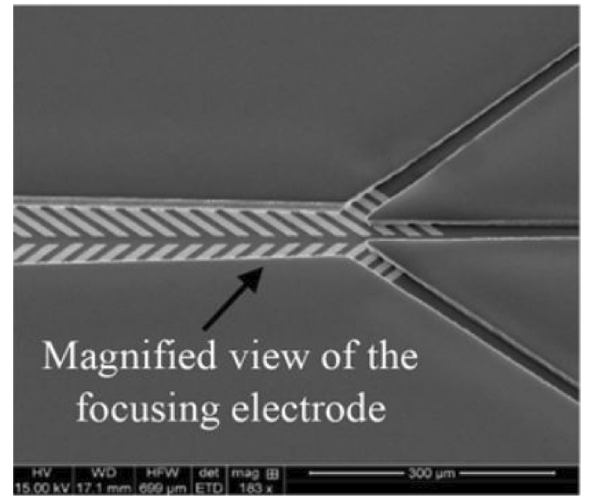
Fig. 26 A surface micromachined resonator device that can be used as microsensor and microactuator